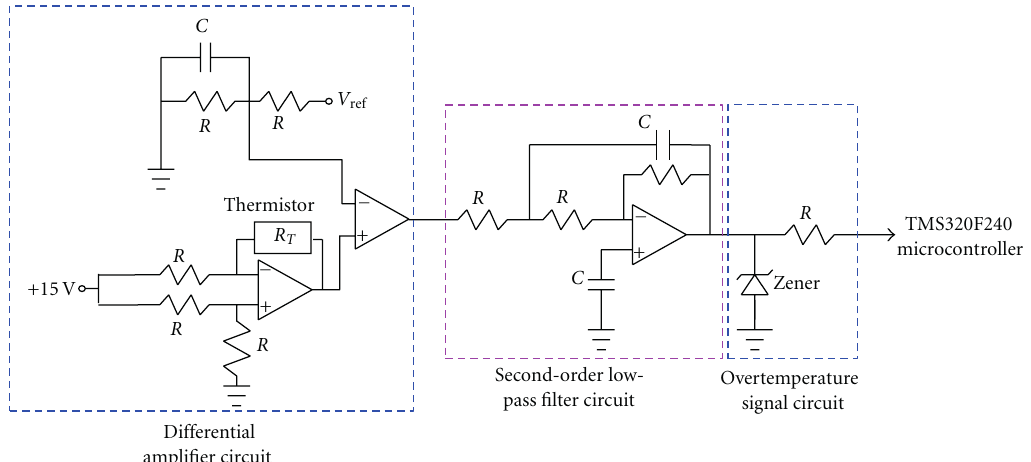
Figure 10: Over-temperature protection circuit of the proposed PV power-generation system.